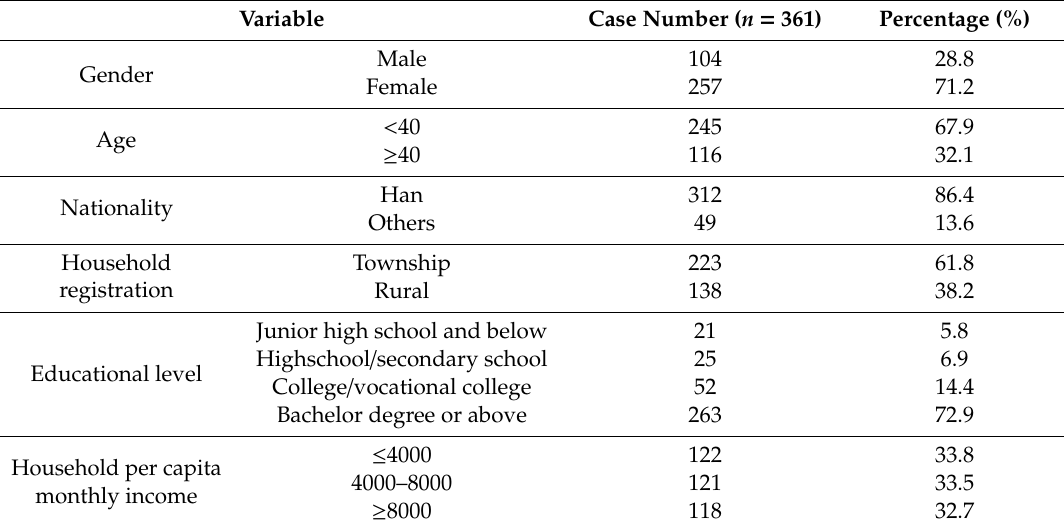
Table 1. Distribution of demographic characteristics (n =